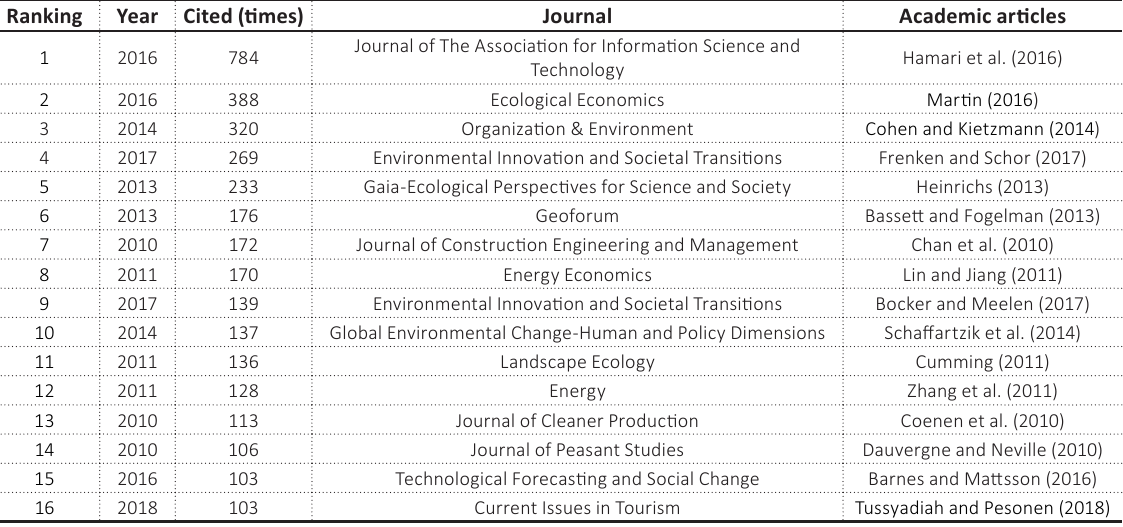
Table 1. 16 most highly cited academic articles on sustainable development in the sharing